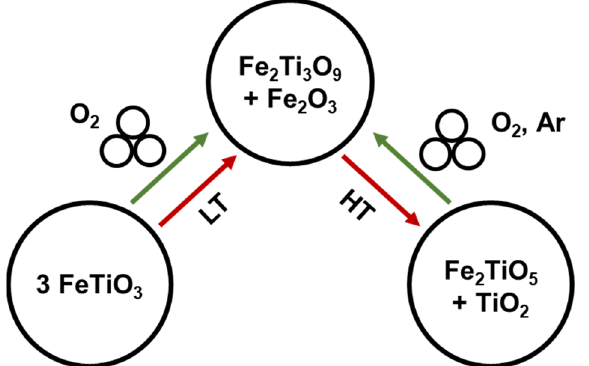
Figure 3. The mechanochemical ball milling (indicated by the three-circles symbol introduced by Rightmire and Hanusa) [28] and thermochemical low-temperature (LT) and high-temperature (HT) transformations of ilmenite. Adapted from [73] .